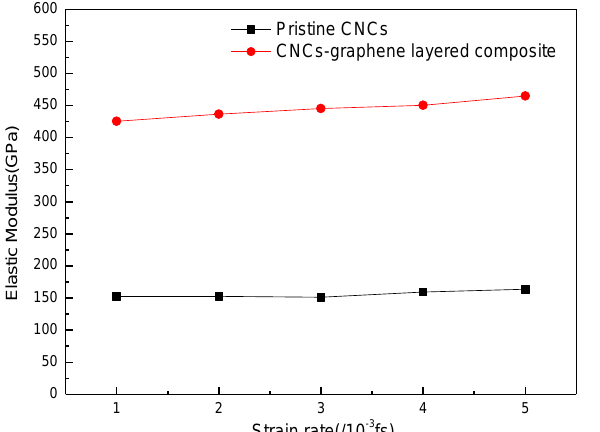
Figure 6. Comparison of the elastic modulus of pristine CNCs and CNCs-graphene layered structure under different strain rates.